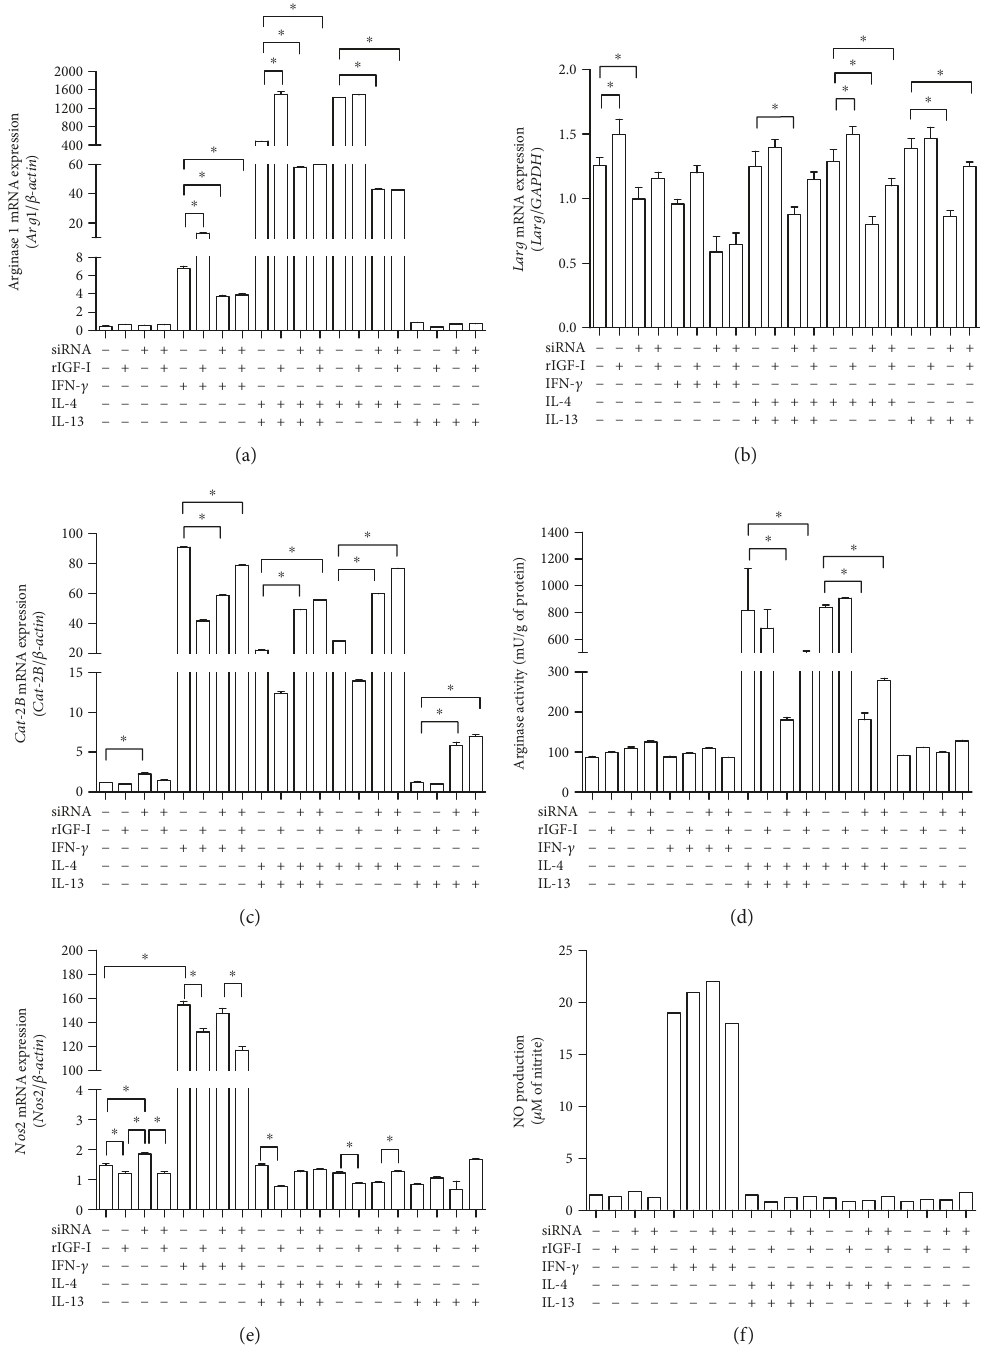
Figure 5: The e ff ects of IGF-I siRNA transfection on the L-arginine metabolic pathway. The quanti fi cation of (a) Arg1 mRNA, (b) Larg mRNA, (c) Cat-2B mRNA, (d) arginase activity, (e) Nos2 mRNA, and (f) NO production in L. major -infected RAW 264.7 cells following transfection with IGF-I siRNA and cytokine stimulation is shown. Promastigote-infected cells transfected with or without IGF-I siRNA were stimulated with IFN- γ (200U/mL), IL-4 (2 ng/mL), and IL-13 (5 ng/mL) for 48hours. One representative experiment from three independent assays is shown. ∗ P < 0 05 (ANOVA and Tukey ’ s tests) compared to the respective control without